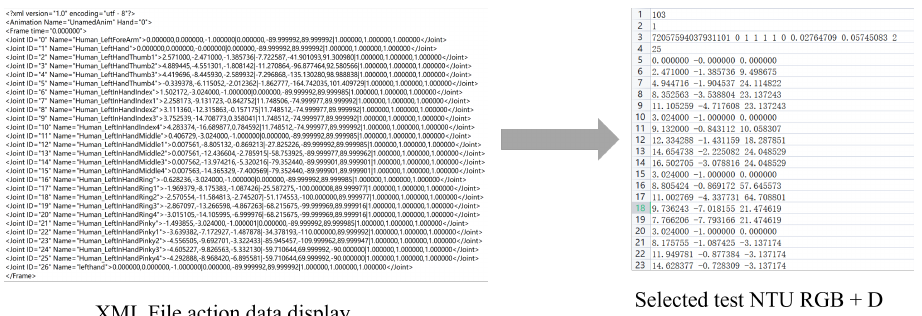
Figure 5. Action data conversion diagram.